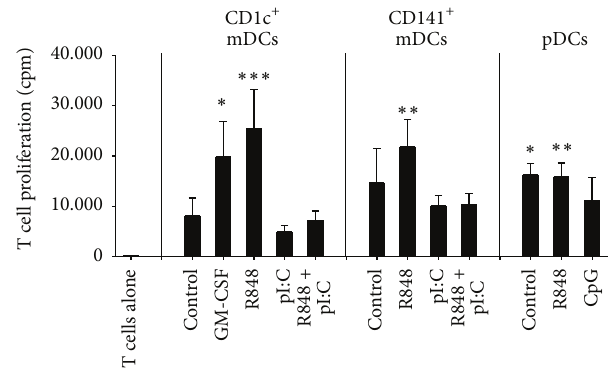
010.00020.00030.00040.000 Figure 3: Human blood DCs induce proliferation of naive CD4 + T cells.HumanCD1c + mDCs,CD141 + mDCs,andpDCswerecultured overnight with the stimuli as indicated. The next day, allogeneic naive CD4 + T cells were added to the DCs (ratio 5 :1). Proliferation was measured at day four of coculture by determining tritiated thymidine incorporation. The graph shows the mean proliferation ± SEM in counts per minute [cpm] ( 𝑛 ≥ 4 ). Each experiment was performed in triplicate for CD1c + mDCs and pDCs and in duplicate for CD141 + mDCs. Significance was tested for each subset in comparison with T cells alone by Kruskal-Wallis test followed by Dunn’s testing ( ∗ 𝑃 < .05 ; ∗∗ 𝑃 < .01 ; ∗∗∗ 𝑃 < .001